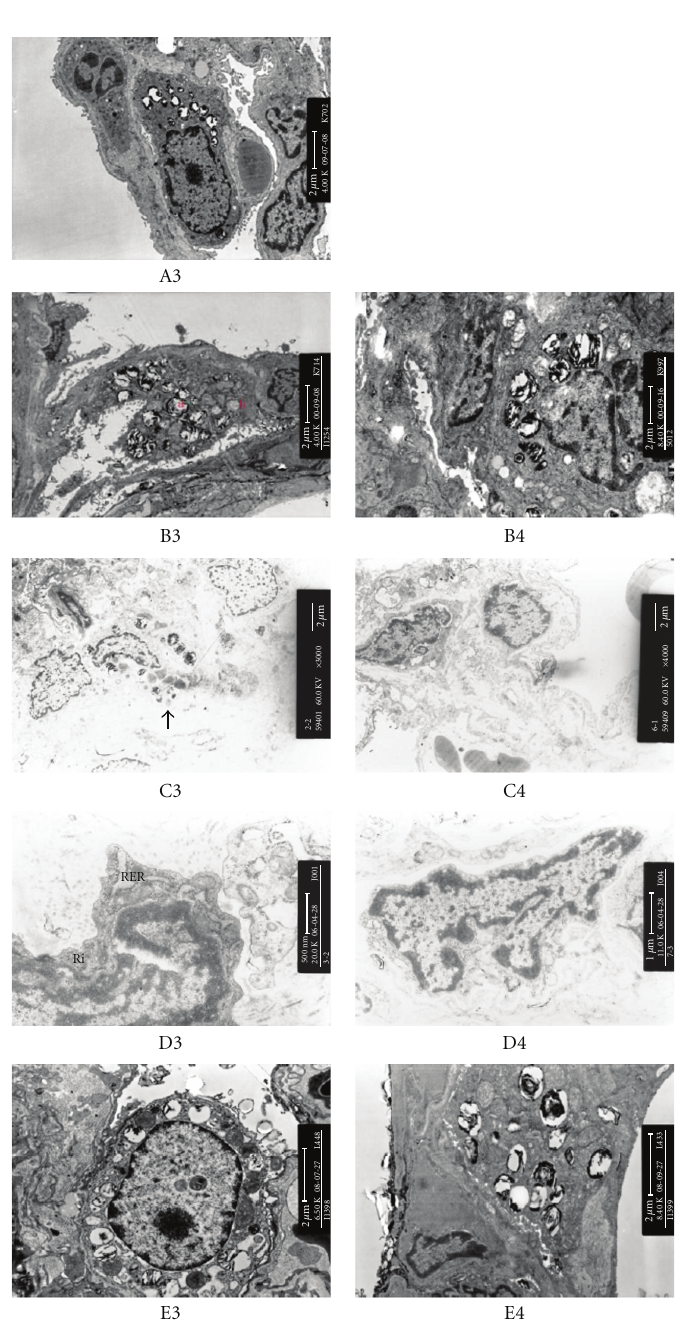
Figure 3: The lung ultrastructure of SD rats from groups of the control, PQ treatment, and PQ+PDTC treatment. Electron micrographs from control group (A3) showed a normal ultrastructure with the presence of pneumocytes type I and II. B3 (PQ group on the 3rd day) and C3 (PQ group on the 7th day) can be observed a type II pneumocyte with mitochondrial swelling (b), dilation of lamellar body (a), pneumocyte necrosis and alveolar collapse ( ↑ ). B4 (PQ+PDTC group on the 3rd day) and C4 (PQ+PDTC group on the 7th day) can be observed normal mitochondria and no alveolar collapse. D3 (PQ group on the 14th day) can be noticed the more numerous rough endroplasmic reticulum (RER) and ribosome (Ri) in fibroblast compared with D4 (PQ+PDTC group on the 14th day). showed E3 (PQ group on the 21st day) can be observed patchy collagen deposition within the expanded interstitium in some areas. E4 (PQ+PDTC group on the 21st day) can be observed a small quantity of collagen